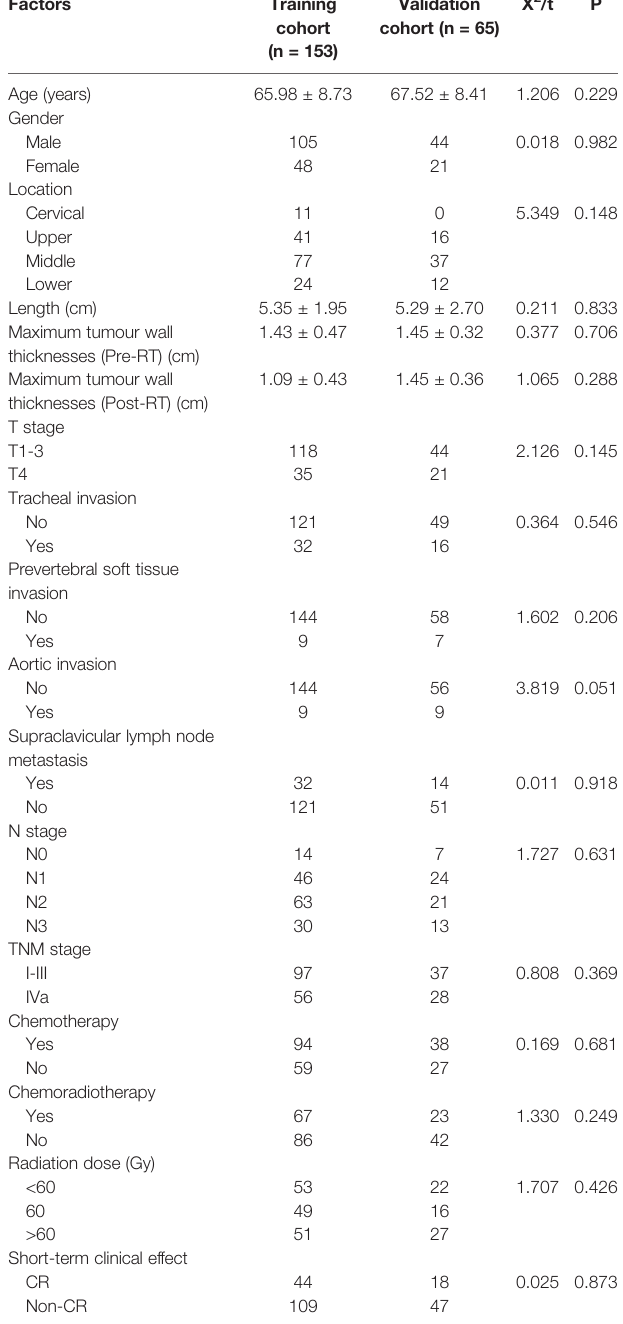
TABLE 1 | The distribution of general clinical factors in the training cohort and validation cohort.